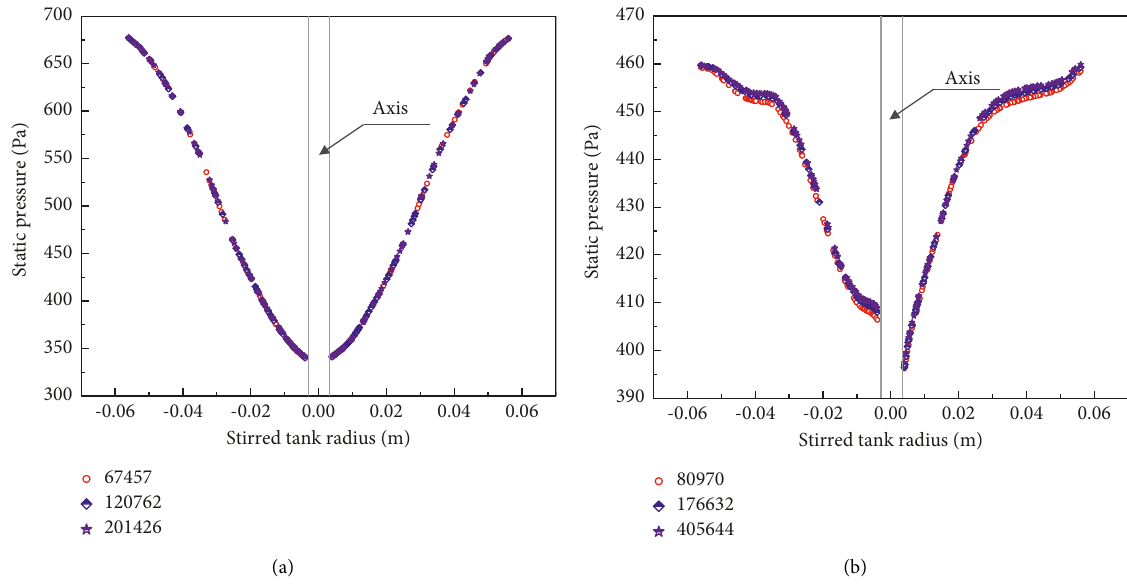
Figure 4: The effect of mesh number on the static pressure. (a) Traditional chromite leaching stirred reactor. (b) Dynamic-static combined chromite leaching stirred